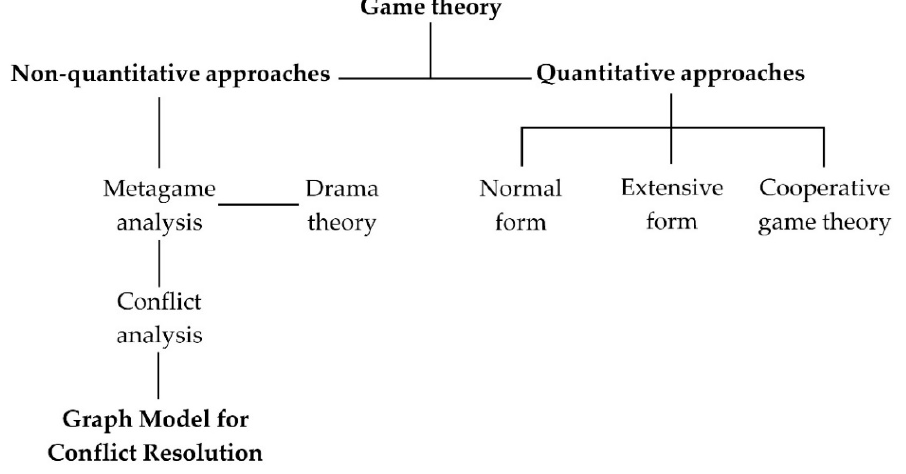
Figure 2. Classification of different models of game theory [68].